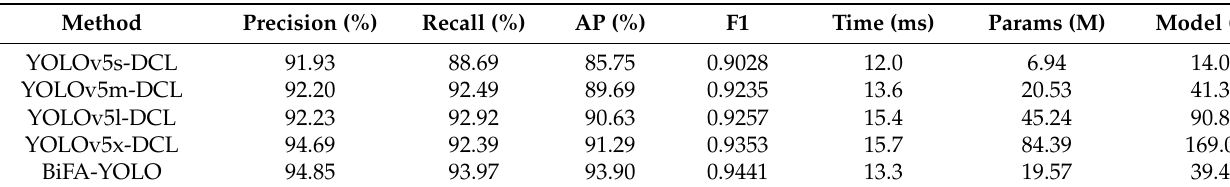
Table 8. Comparison of different models using the DCL on SSDD.